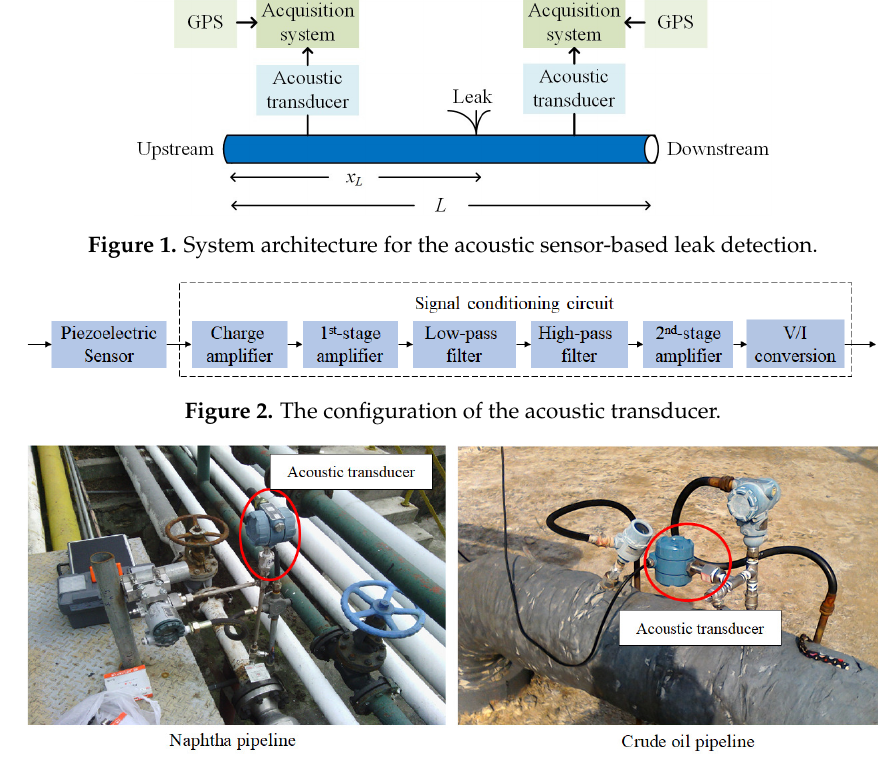
Figure 3. Field installation of the acoustic transducers on